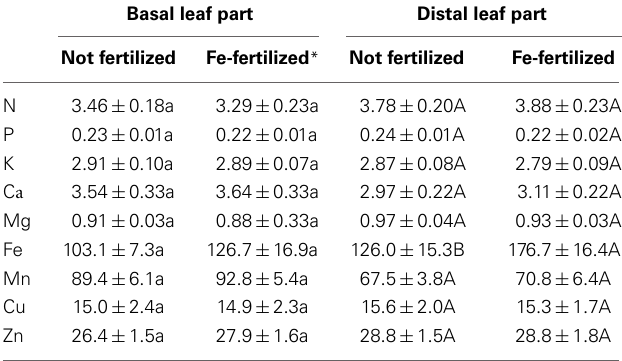
Table 1 | Concentrations of macro- (N, P, Ca, Mg, and K; in % DW) and microelements (Fe, Mn, Cu, and Zn; in μ g g − 1 DW) in basal and distal parts of Fe-deficient peach tree leaves either not fertilized or 8 weeks after the first treatment with 2mM FeSO 4 and 0.1%